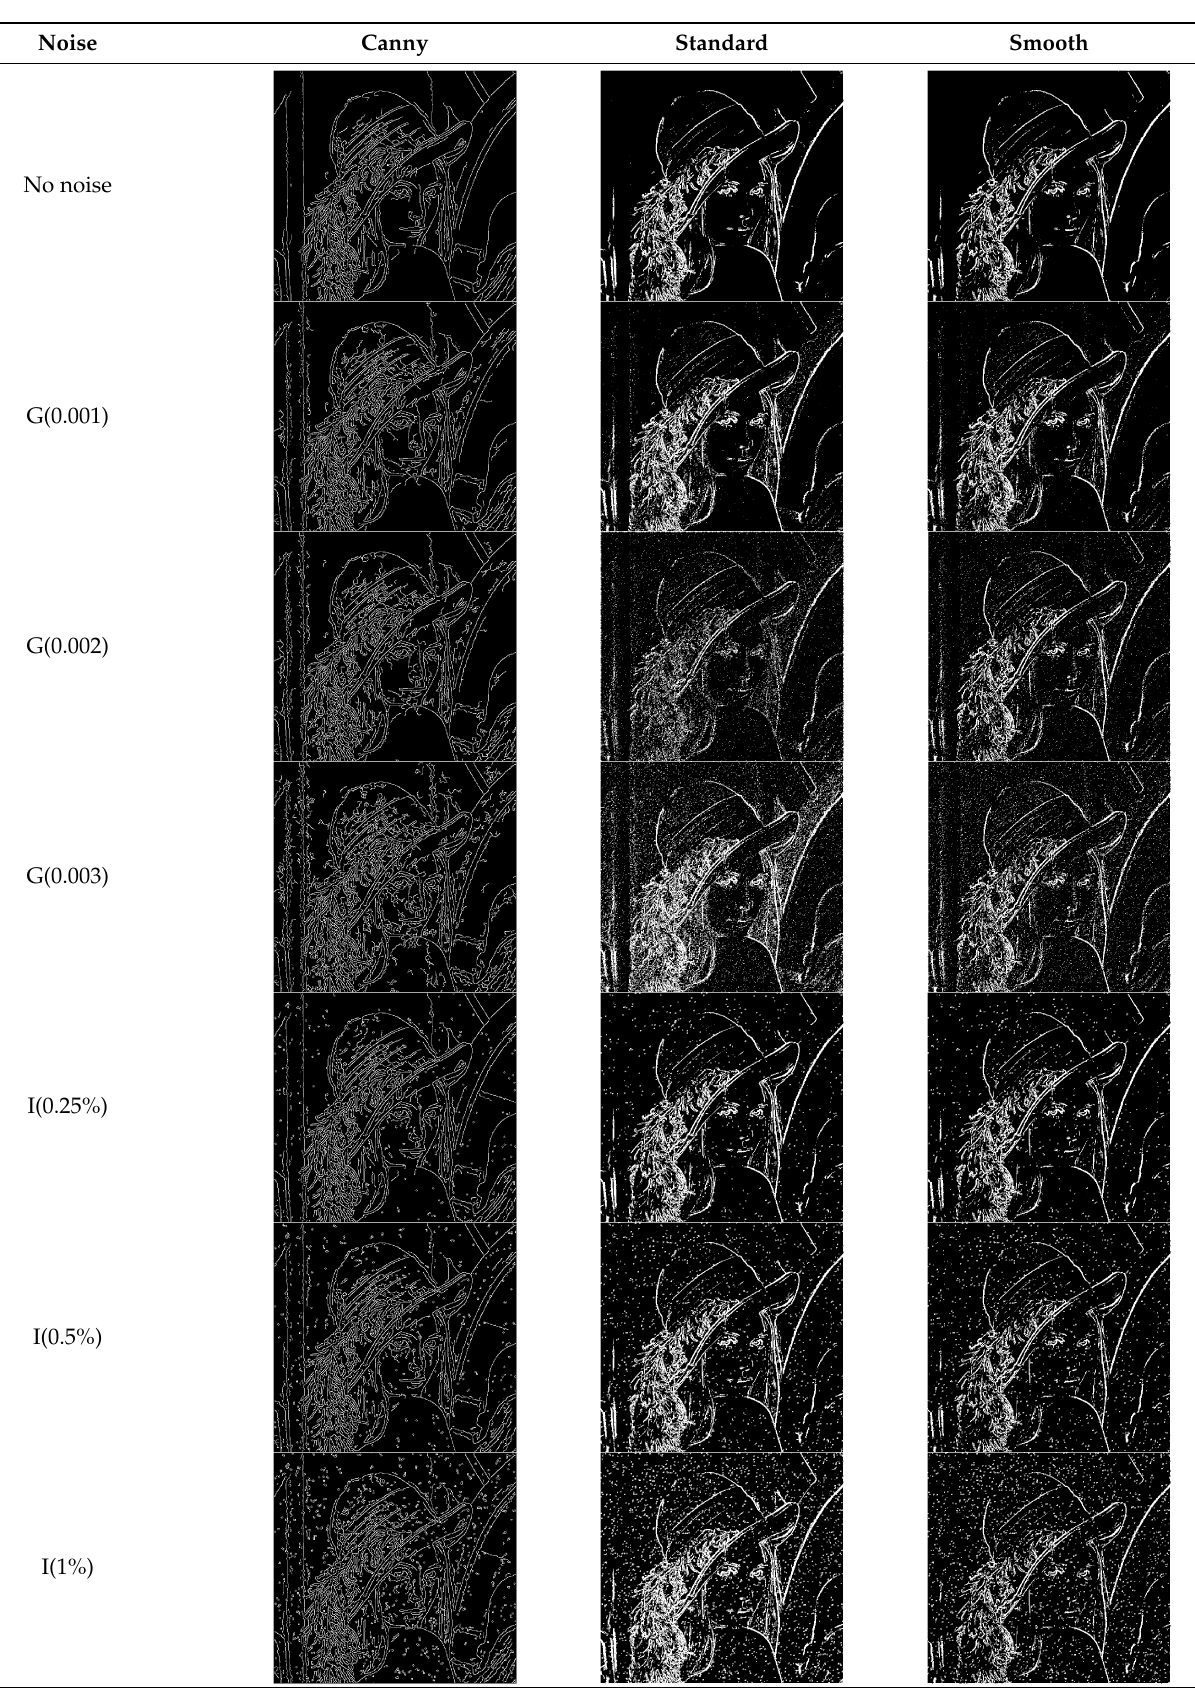
Table 8. Edge-detected image of “Lena” after binarization for different